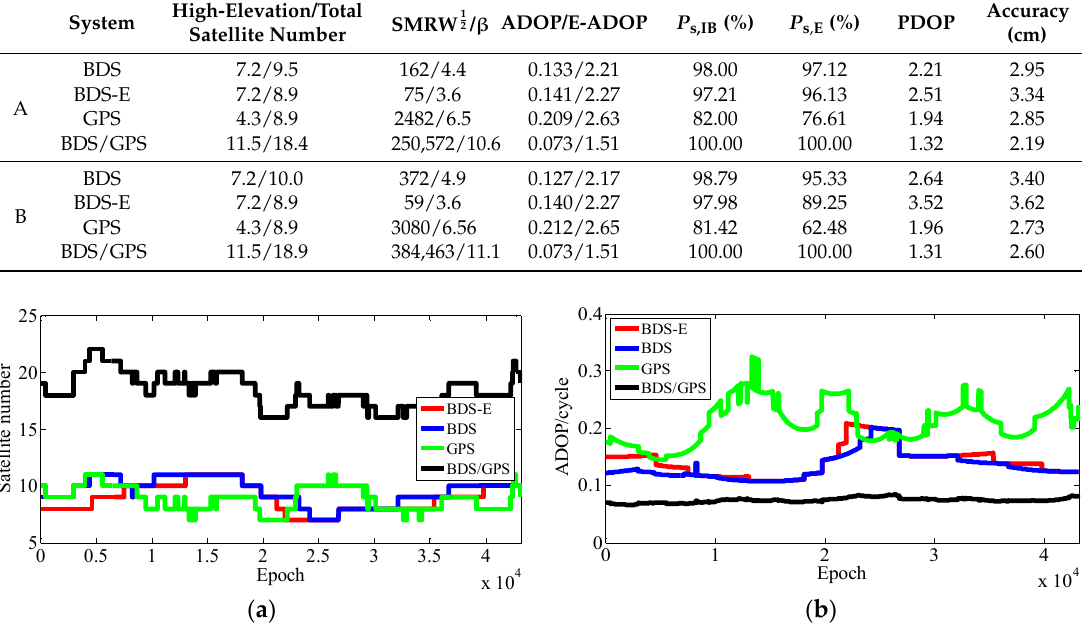
Figure 15. Satellite number and ADOP of four systems for group A. ( a ) The satellite number of four systems for group A. ( b ) The ADOP of four systems for group A.